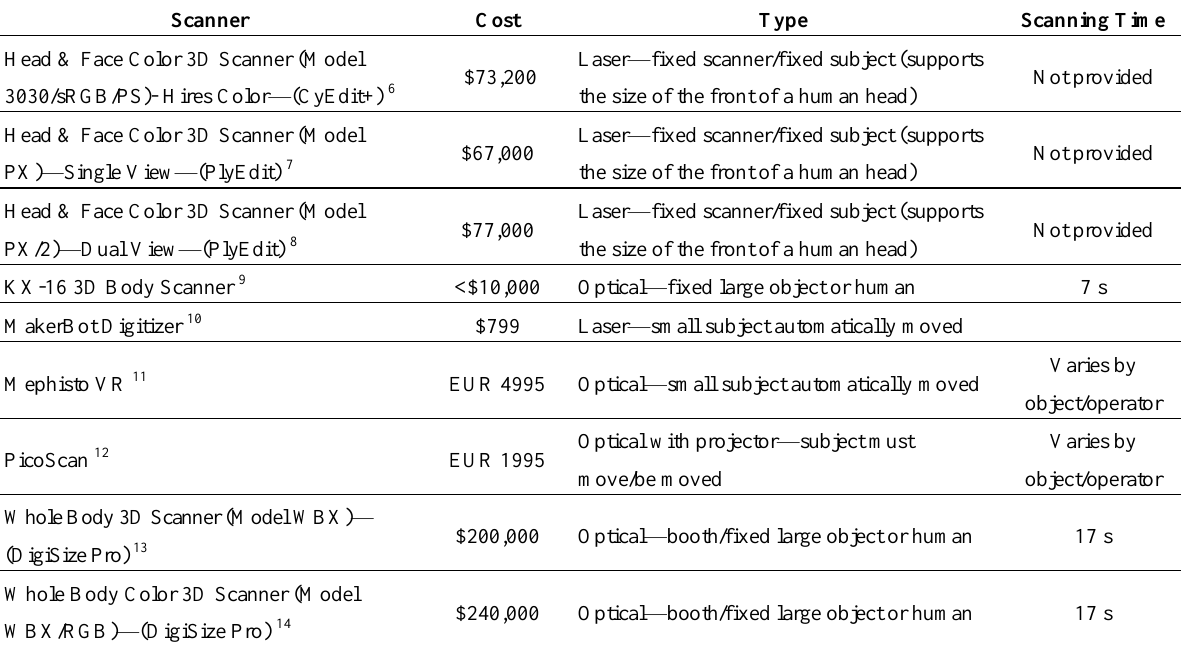
Table sources: 1 http://cubify.com/en/Products/Sense; 2